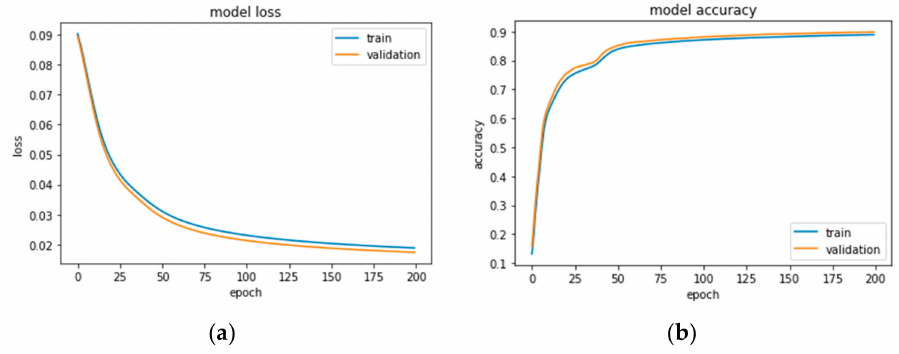
Figure 13. Training process of the network, ( a ) loss, ( b )